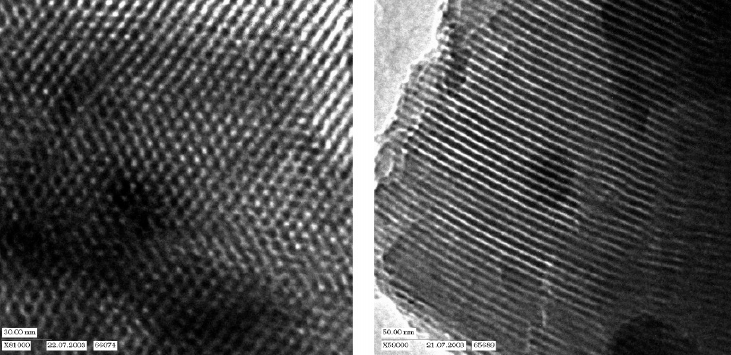
Figure 1. Figure of the PXRD profiles of the biphenylene-bridged periodic mesoporous organosilicas (PMO) is presented. ( a ) The as-made material containing surfactants, ( b ) the surfactant-free material obtained by solvent extraction [9].